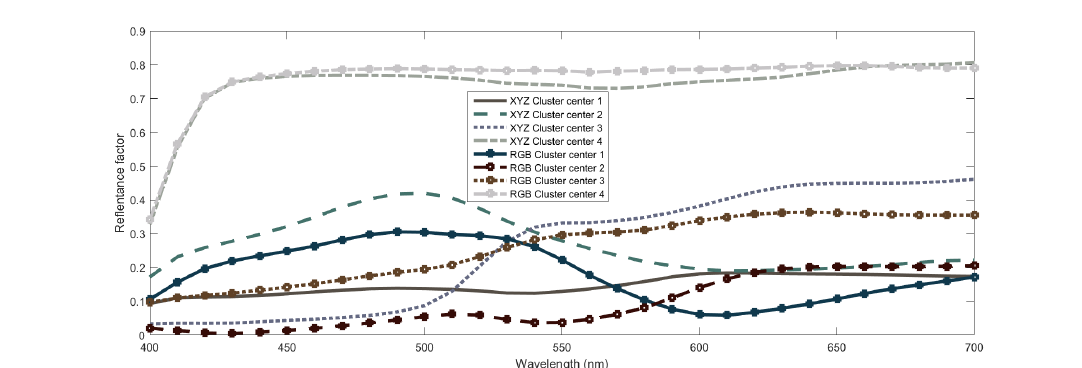
Figure 16. Spectral curves associated to cluster centers obtained in the FIS using both CIEXYZ and RGB data. For each center, the corresponding RGB coordinates are used to plot the curve.